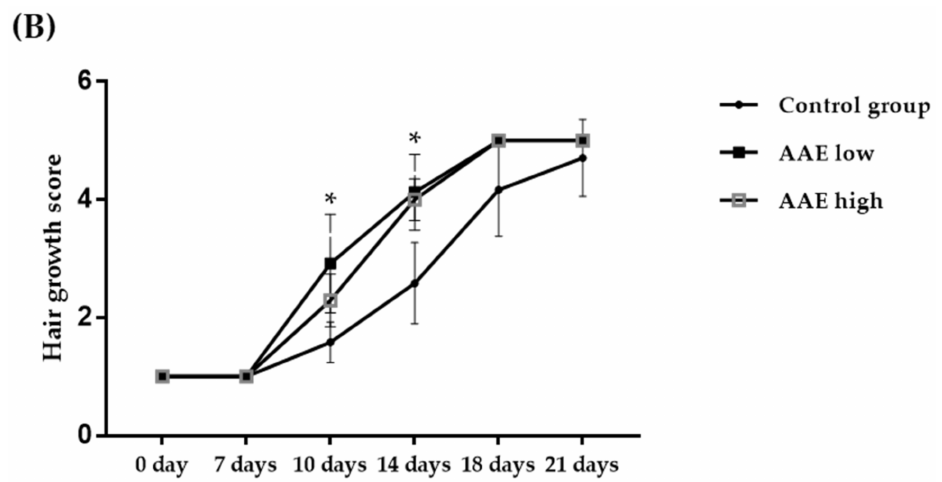
Figure 1. Effects of Annurca apple extract (AAE) on hair growth in C57BL/6 mice. Mice in the telogen hair phase were orally given low (160 mg/kg/d) and high (320 mg/kg/d) doses of AAE once a day for 21 d. Hair growth was measured after days 0, 7, 10, 14, 18, and 21 ( A ). Hair growth score was designated as 1, 2, 3, 4, and 5 corresponding to 0–19%, 20–39%, 40–59%, 60–79%, and 80–100% re-growth ( B ). Data are presented as mean ± SD ( n = 6), * p < 0.05 compared with the control group. AAE low, Annurca apple extract at low concentration; AAE high, Annurca apple extract at high concentration.